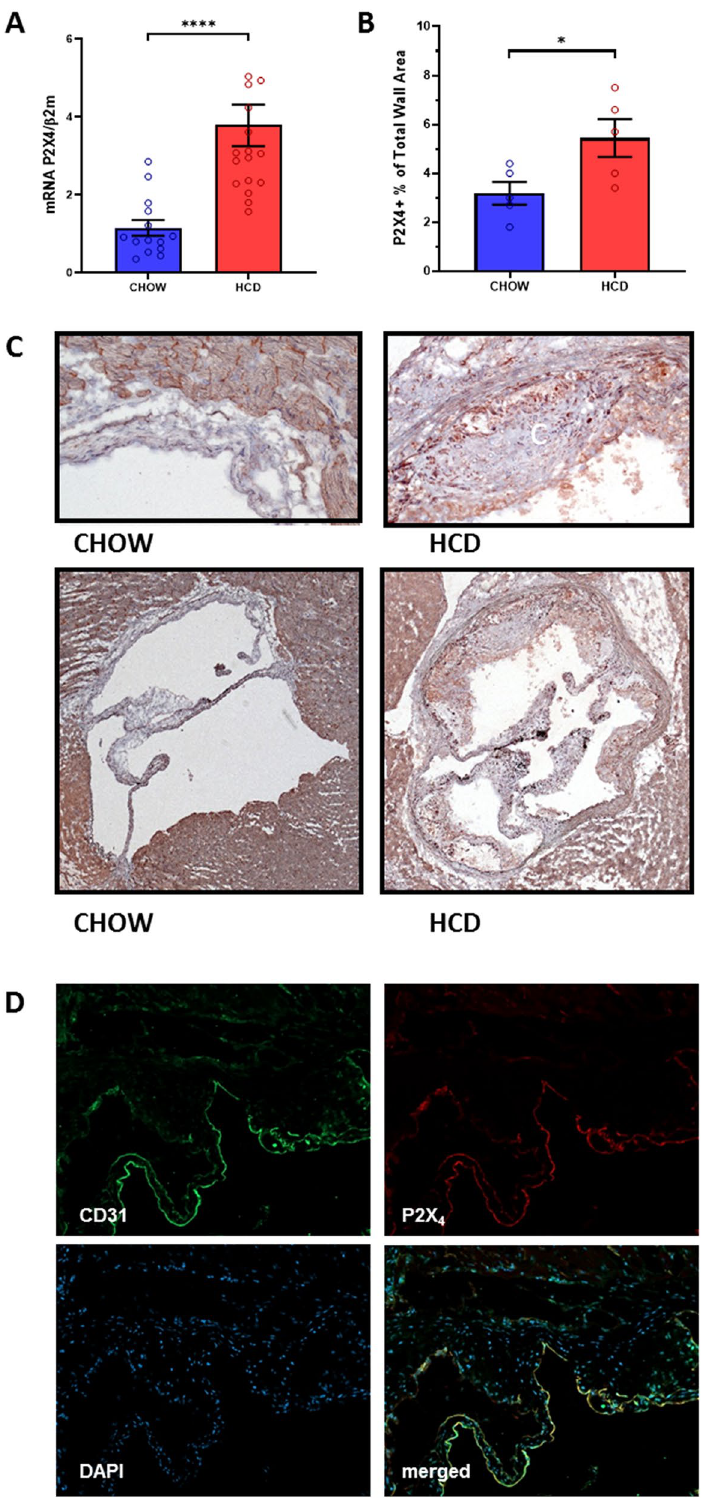
Figure 1. P2X 4 is expressed murine atherosclerosis. LDL-R −/− mice consumed either a high cholesterol diet (n = 16) or a chow diet (n = 14) for 16 weeks. After diet, RNA was isolated from aortic arches and P2X 4 expression was assessed by quantitative polymerase chain reaction ( A ). Aortic roots (n = 10) were stained with anti-P2X4, and P2X 4 -positive staining area were quantified within the aortic sections ( B , C ). Distribution of P2X 4 in atherosclerotic lesions from LDLR −/− mice (n = 15) was analyzed by 3-colour immunofluorescence staining for cell nuclei (DAPI, blue), endothelial cells (CD 31, green) and P2X 4 (red). Representative sections are shown in the merged images ( D ). Results are presented as mean ± SEM. Statistical significance was calculated using unpaired t-test (parametric data) or Mann–Whitney- U -test (non-parametric data). * p < 0.05; **** p <